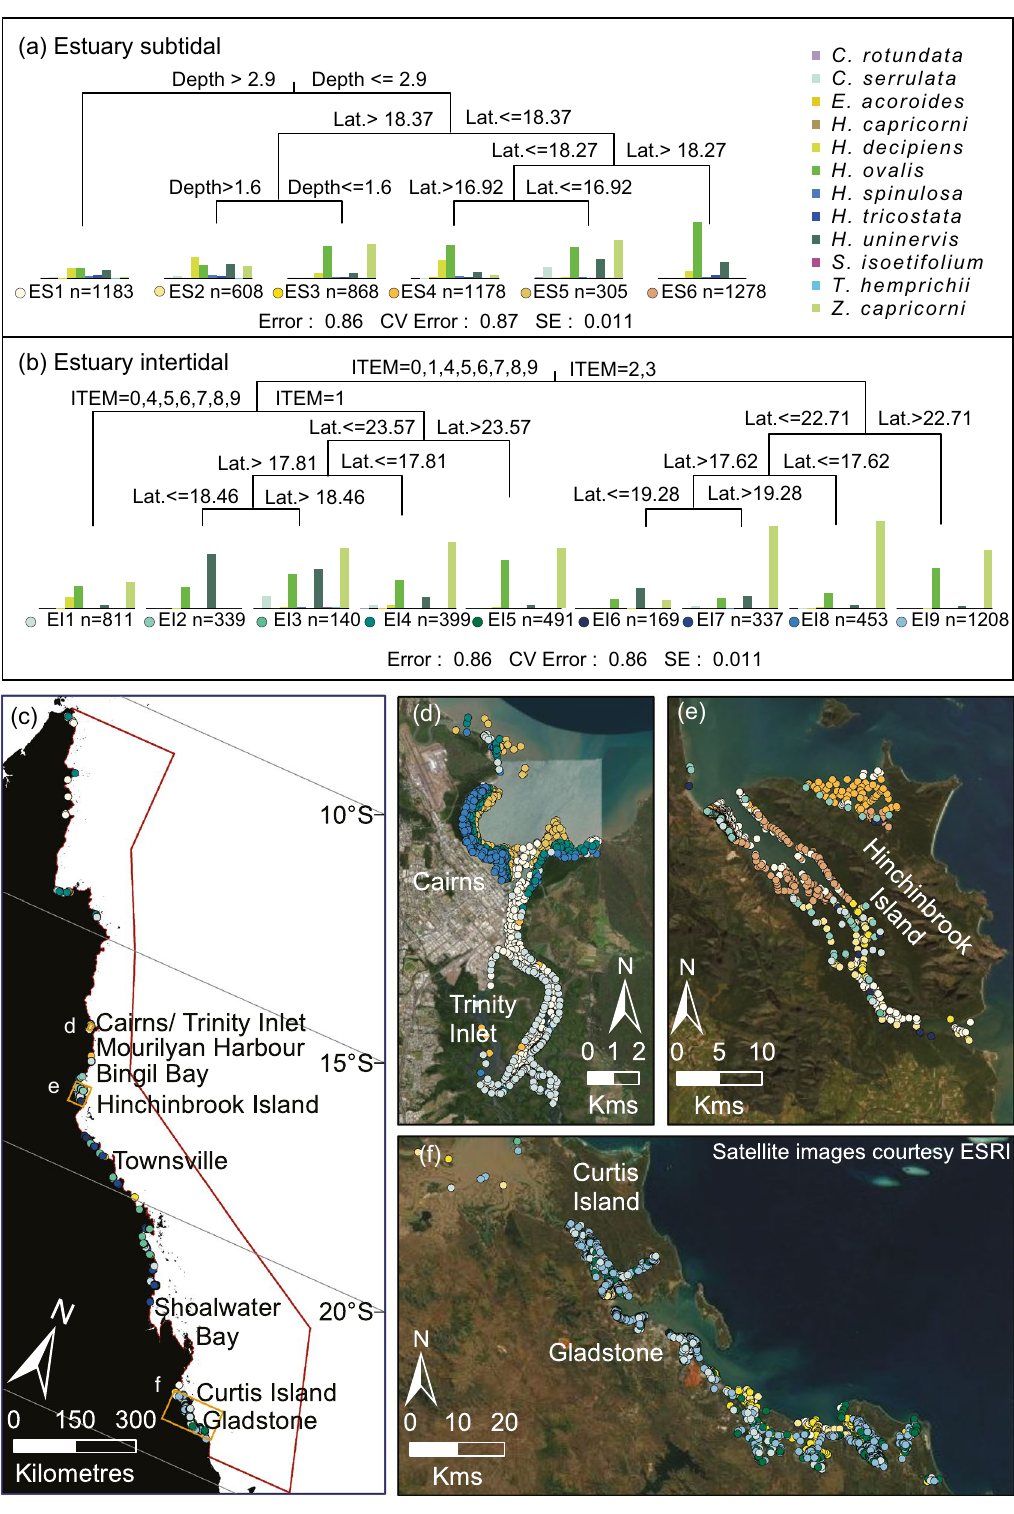
Figure 5. Multivariate regression tree (MRT) and seagrass communities classified for estuaries using species presence/absence data for ( a ) subtidal sites and ( b ) intertidal sites. The number (n) below each community is the count of observations that fall into that community. The histogram shows the frequency of occurrence for each species in that community with the height of the bar representing the frequency that each species was observed in that assemblage. The coloured dots represent unique communities for coast intertidal (EI) 1–9, and coast subtidal (ES) 1–6. The CV Error is the cross-validated relative error. (c) The spatial distribution of communities across the Great Barrier Reef World Heritage Area (red border), and (d-f) finer-scale maps of communities at select locations. Map created using ArcGIS software version 10.8 by Esri (www. esri. com). Satellite image copyright